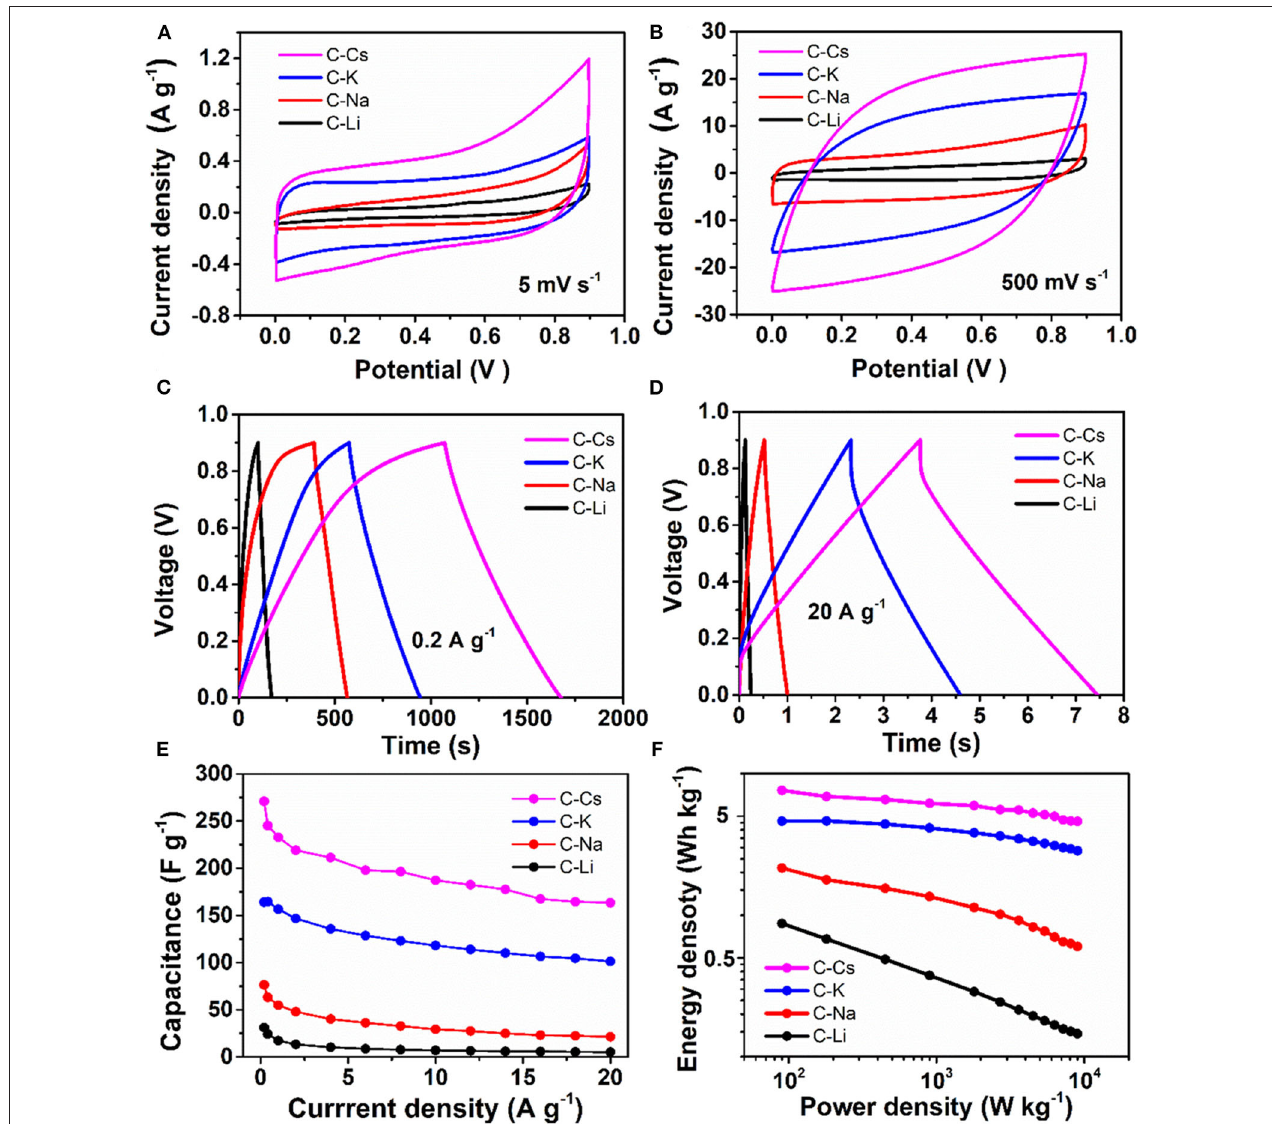
FIGURE 5 | Supercapacitive properties for C-Ms: (A,B) Cyclic voltammograms for at scan rates of 5 and 500mV s − 1 ; (C,D) galvanostatic potential curves at a current density of 0.2 and 20A g − 1 ; (E) Specific capacitance at different current densities; (F) Ragone